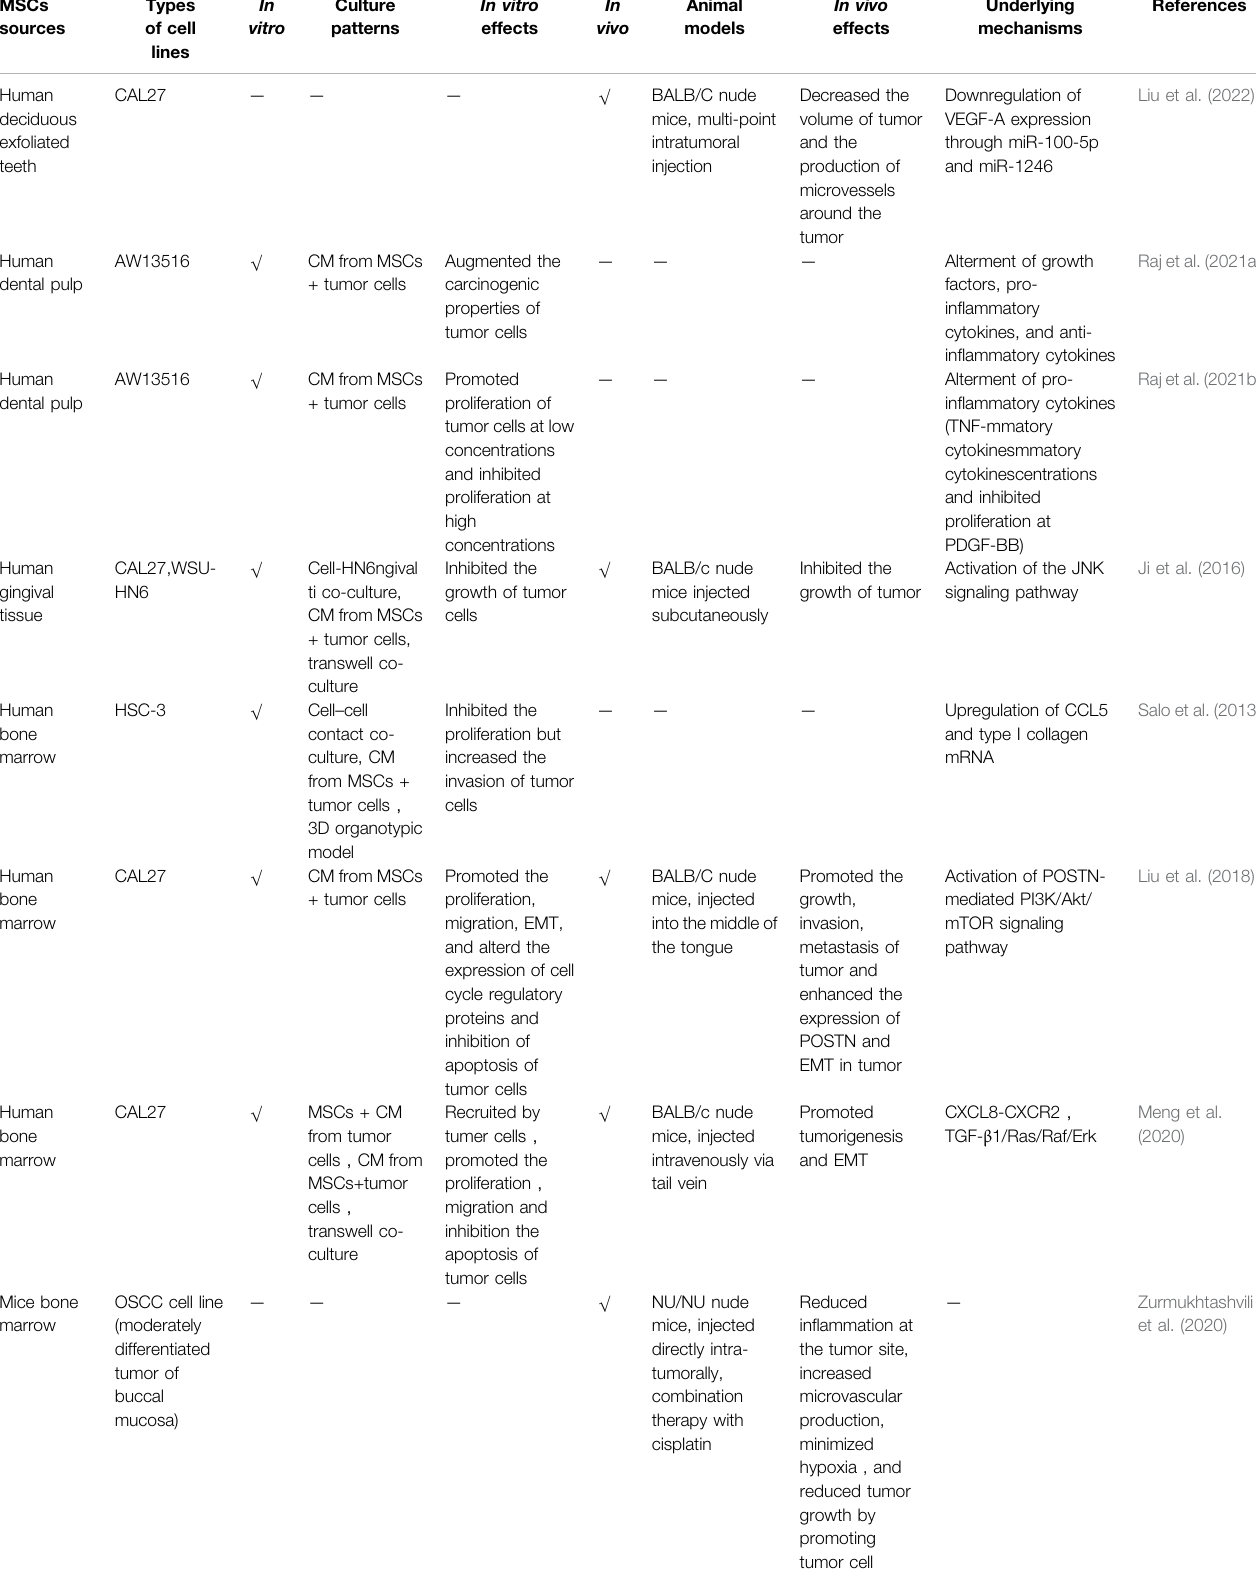
TABLE 1 | Effects of MSCs on oral